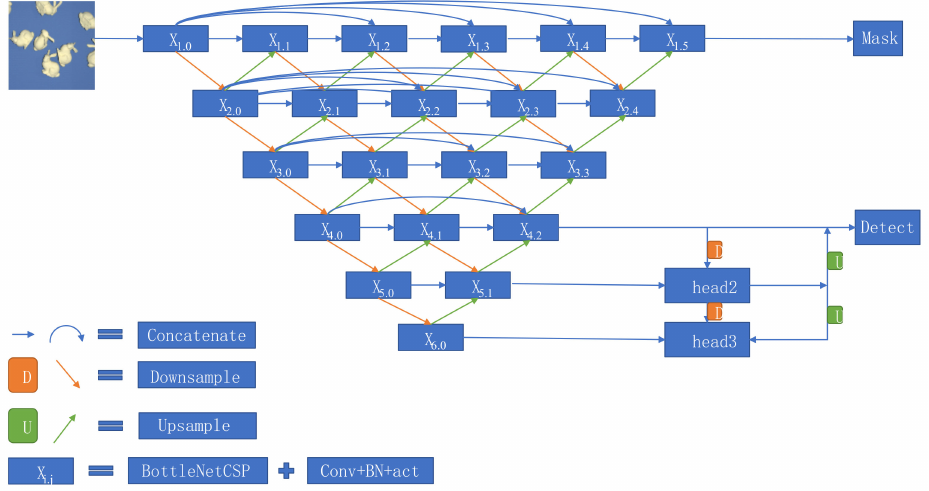
Figure 2. Network architecture of the proposed